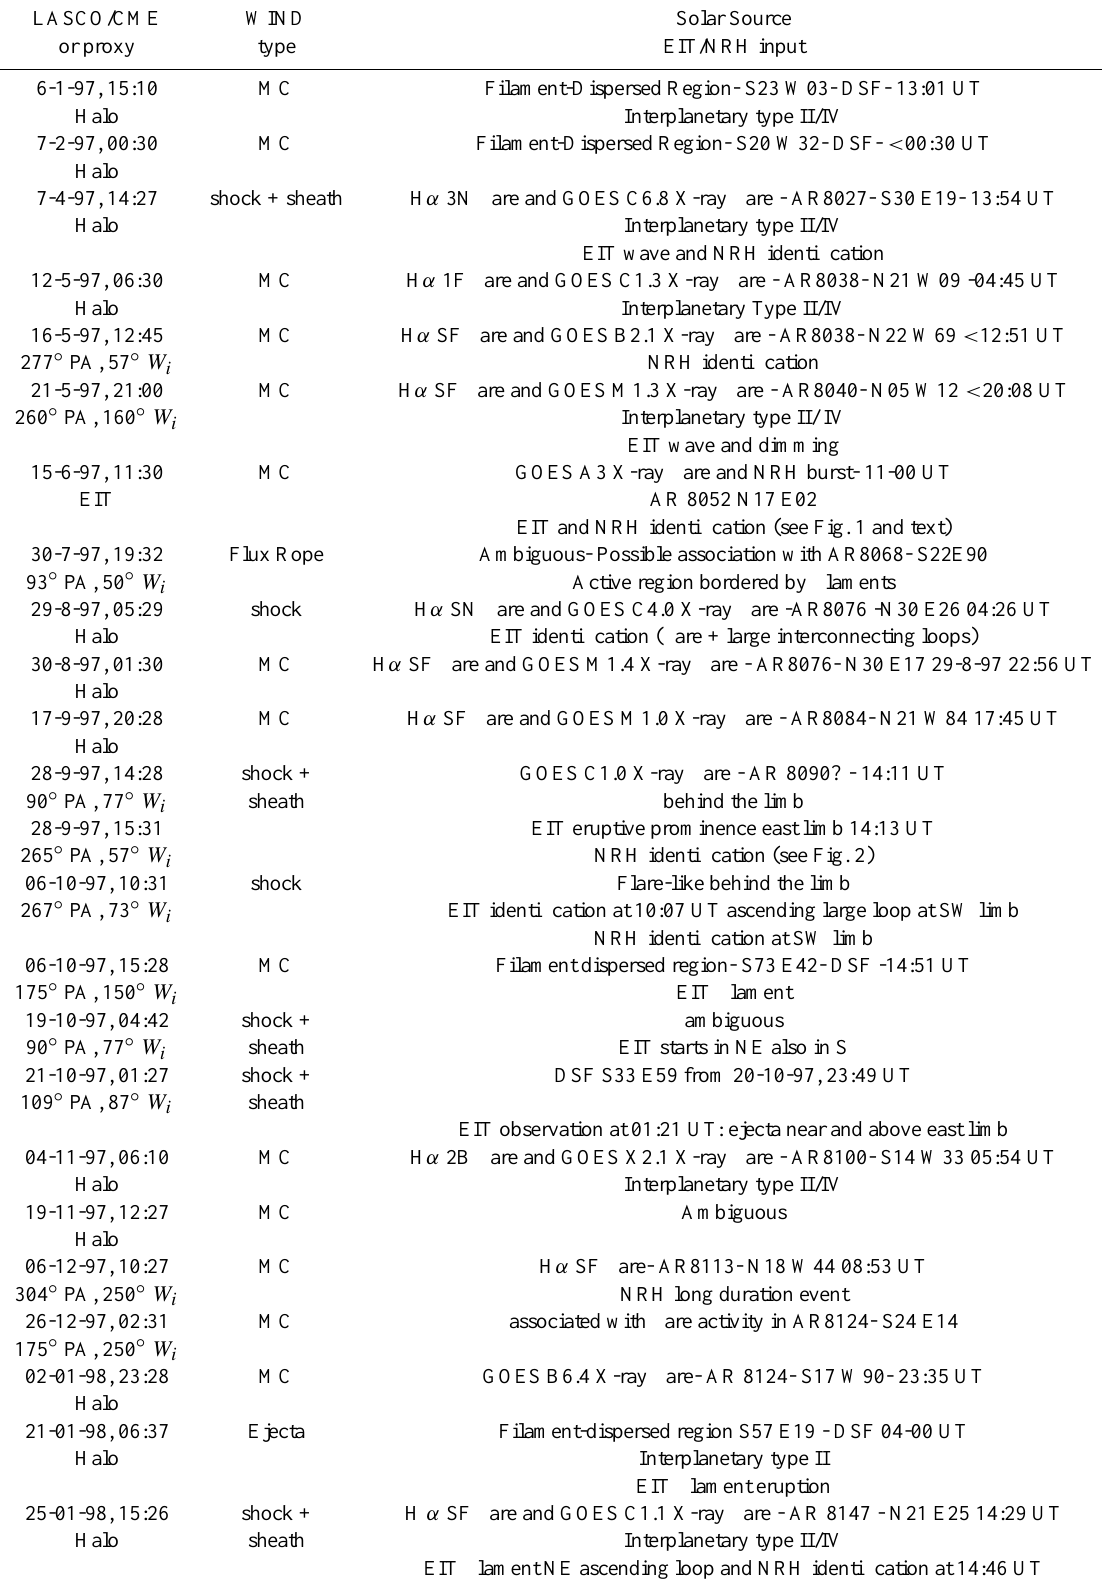
Table 2. Solar Origin of CMEs and interplanetary events